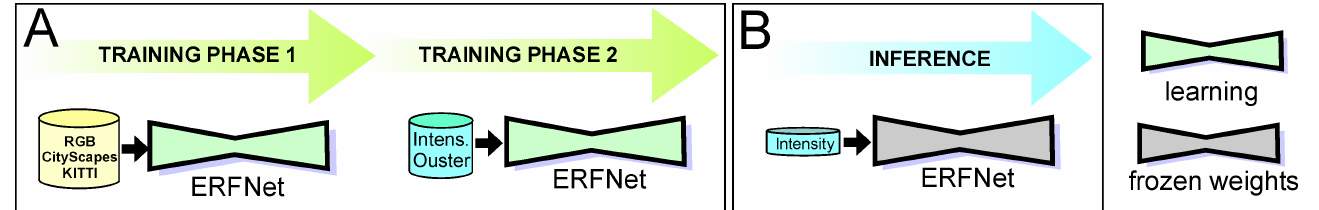
Figure 4. Training of the ERFNet neural network model using the labelled grayscale (Phase 1) and intensity (Phase 2) images ( A ), and the inference process for detection of non-stationary objects using intensity images and the learned semantics ( B